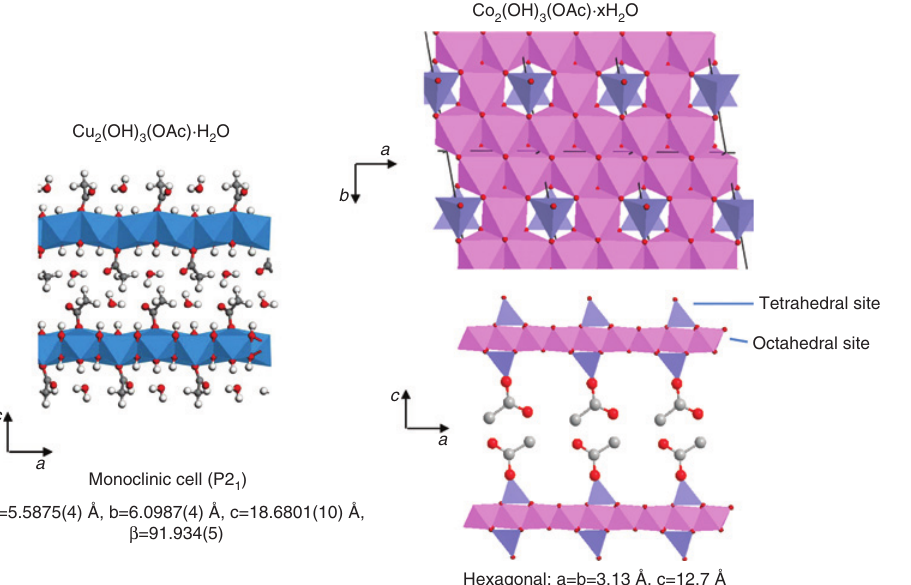
(OH) (OAc)·H O (left) [73, 74] and Co 2 3 2